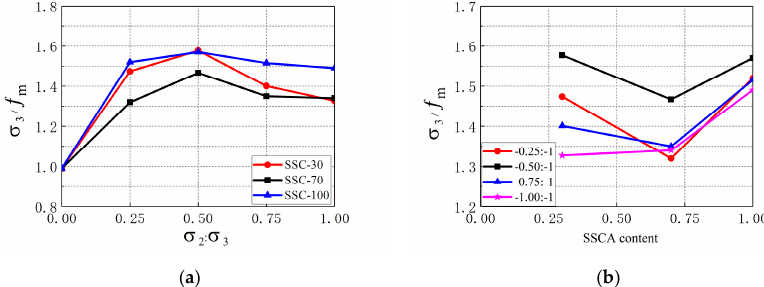
Figure 5. Influence of stress ratio and SSCA replacement ratio on σ 3 f / f m . ( a ) σ 3 f / f m with di ff erent stress ratios; ( b ) σ 3 f / f m with di ff erent SSCA replacement